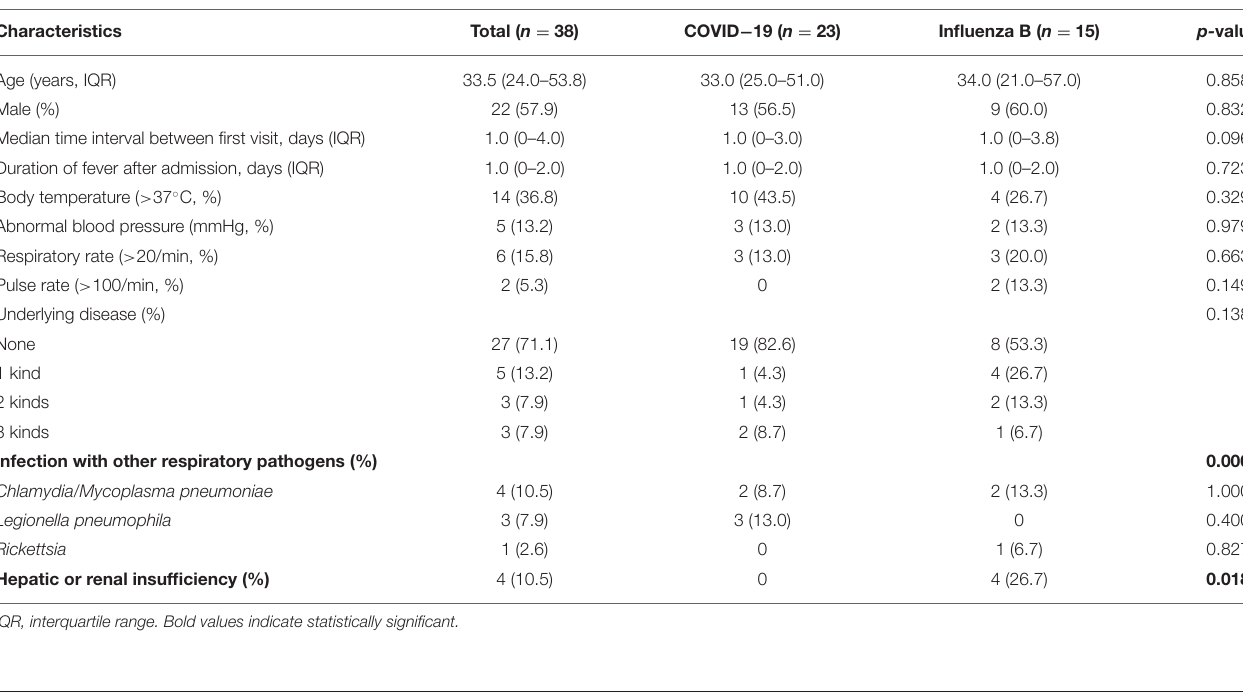
Frontiers in Medicine |